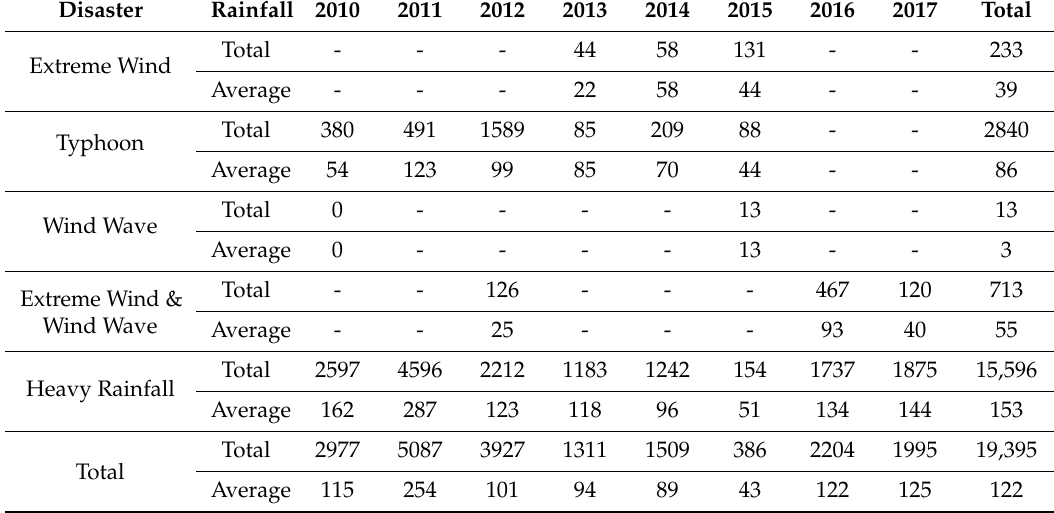
Table 4. Annual total and average rainfalls of inundation damage occurrences by natural disaster type. Disaster Rainfall 2010